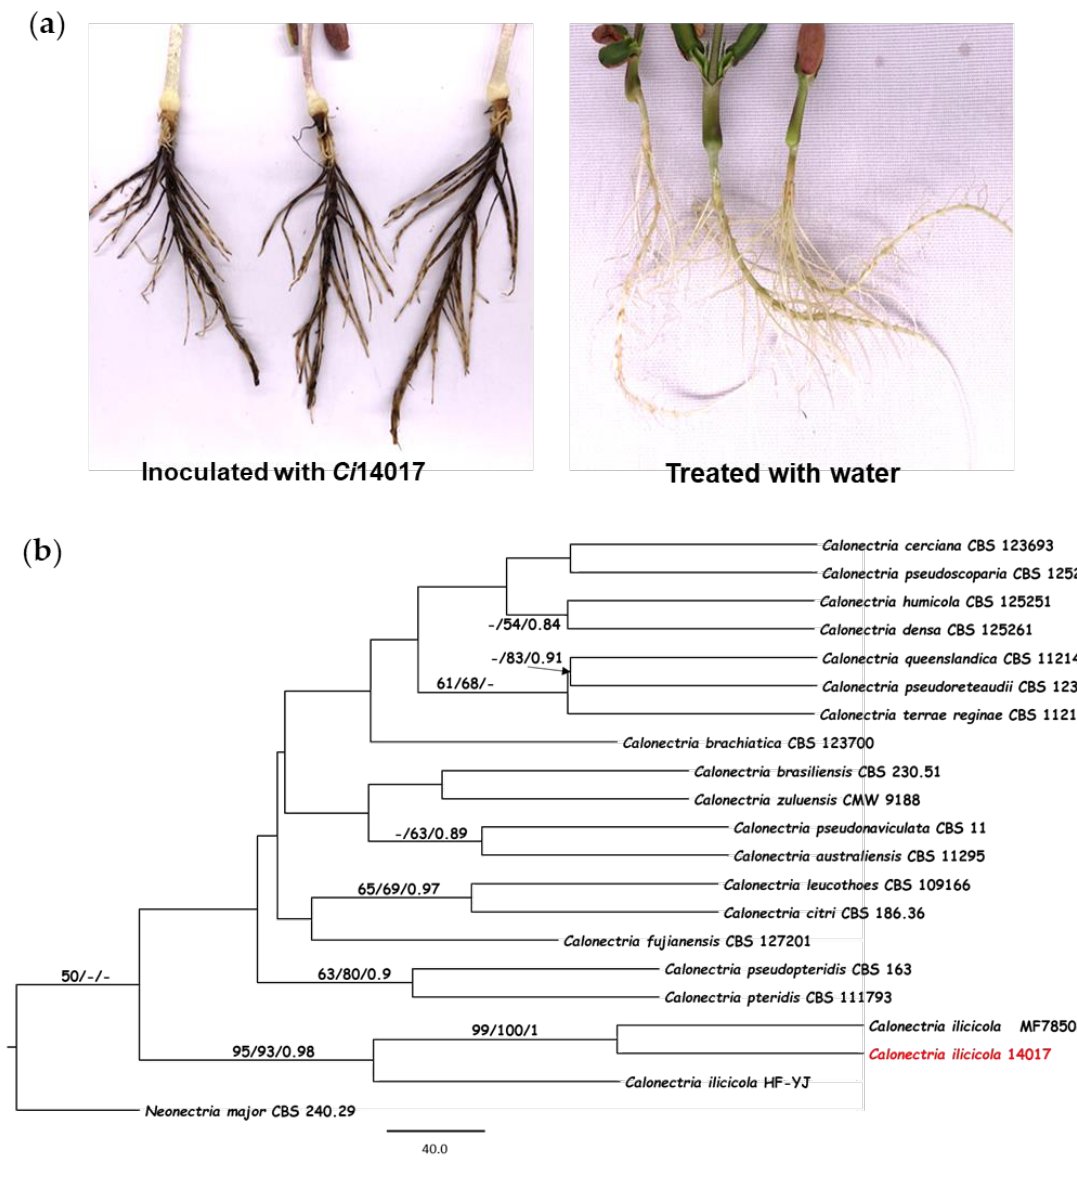
Figure 1. Isolation and identification of the C. ilicicola Ci 14017. ( a ) The CBR symptoms on peanut roots inoculated with Ci 14017. ( b ) Phylogenetic tree established from the ITS region of Ci 14017. The phylogenetic tree based on Maximum likelihood, Maximum parsimony and MrBayes analysis, the bootstrap support rate of the three is merged into the ML evolutionary tree. The arrow in the figure points to the branch where the bootstrap support rate is located.